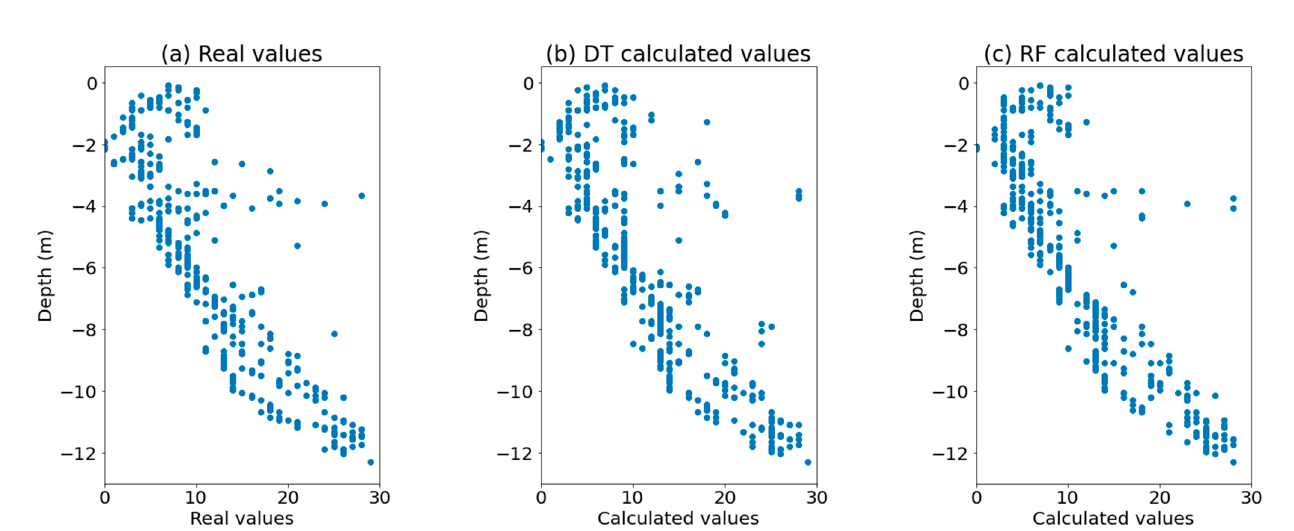
Figure 15. Real and calculated values for site 1 considering depth. ( a ) Real values. ( b ) Values calcu- lated by DT. ( c ) Values calculated using RF.